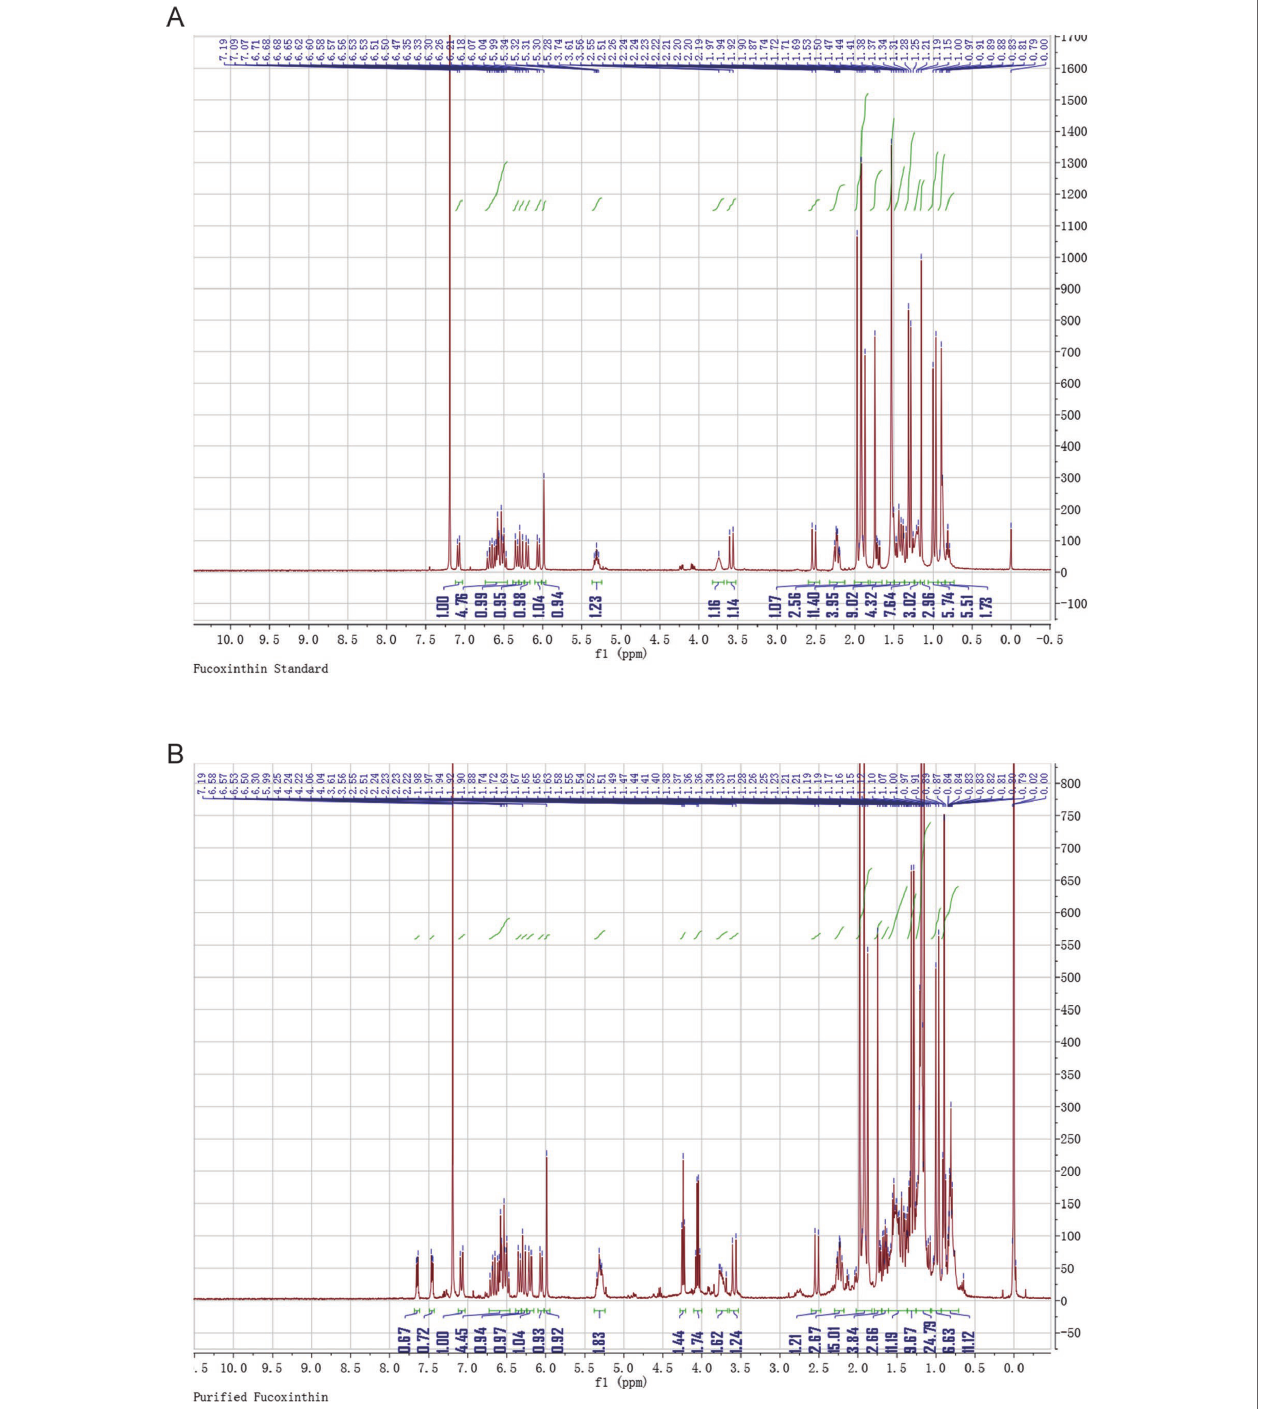
FIGURE 3 | Nuclear magnetic resonance spectroscopy of the standard fucoxanthin (FX) (A) and ND-8 FX